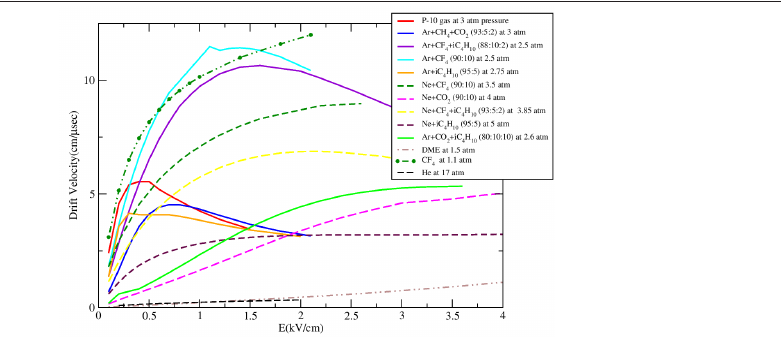
Figure 3. Electron drift velocity as a function of field for various gas mixtures obtained using